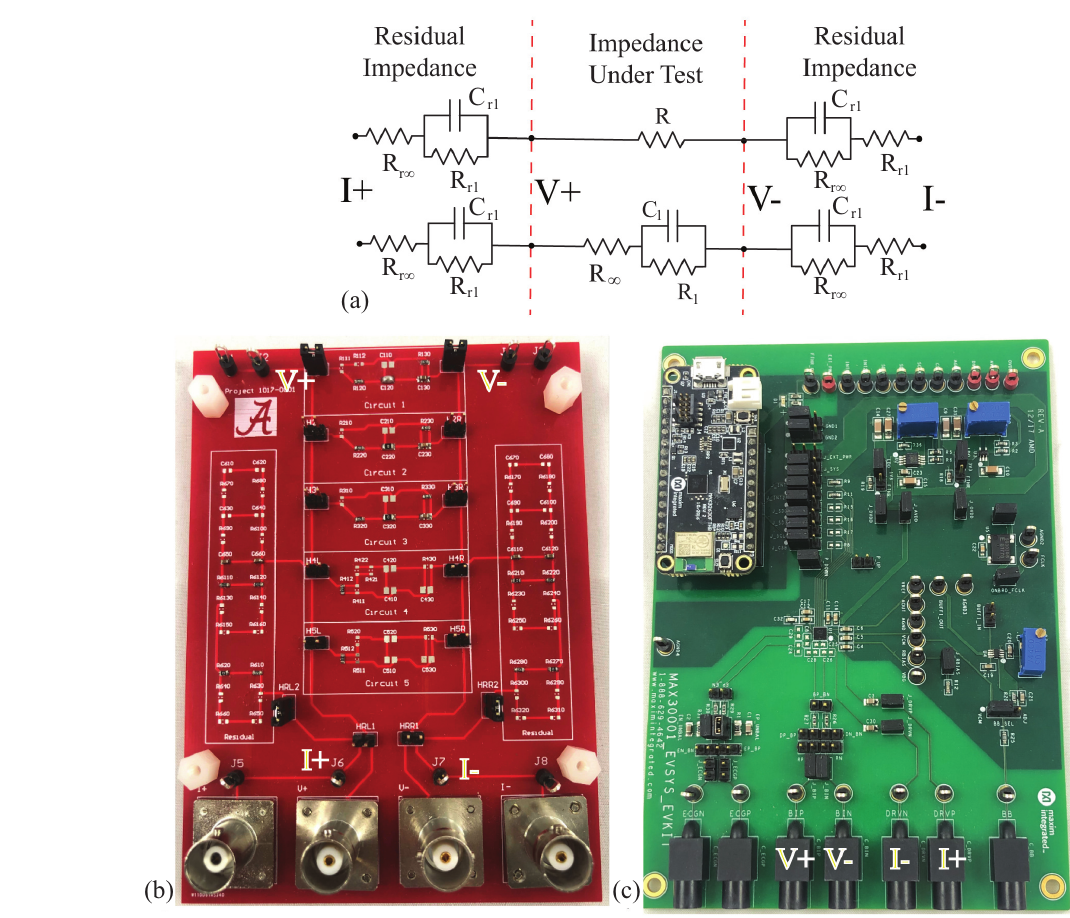
Figure 4. ( a ) Electrical schematic of topologies with series residuals, ( b ) realized using a PCB populated with discrete surface-mounted components, which was ( c ) measured using the MAX3000x to characterize the performance of this IC for measuring both resistance and reactance in the range representative of localized bioimpedance